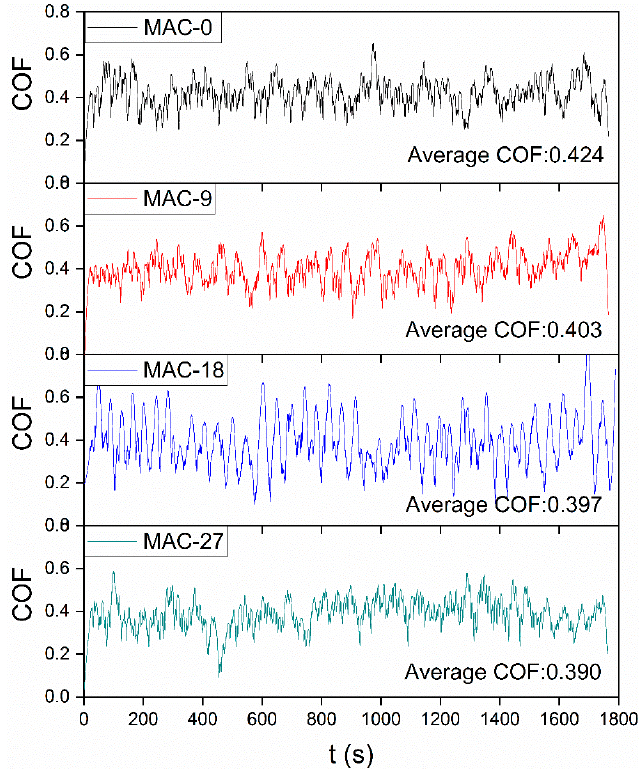
Figure 5. Friction coefficient curves of the Ti-45Nb samples.